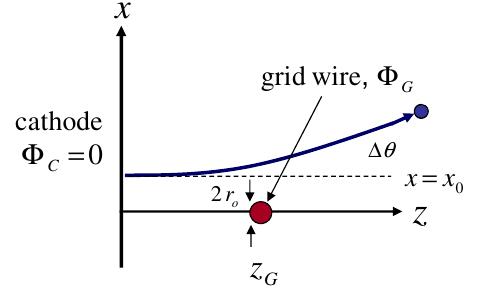
FIG. 7. Calculation of emittance due to a single grid wire. Here the cathode is at ground potential and located at z ¼ 0 , the grid wire is at potential (cid:2) G , located at z ¼ z G , and has radius r o . An is deflected through an angle electron with impact parameter x 0 (cid:1) (cid:5) due to grid